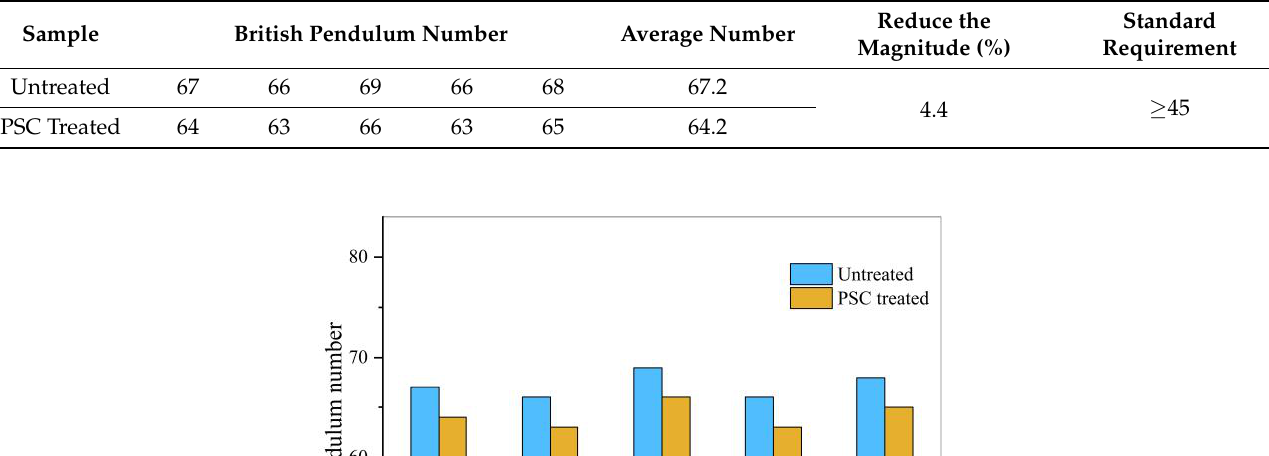
Figure 10. Pendulum number test results. Table 6. Pendulum number test results.